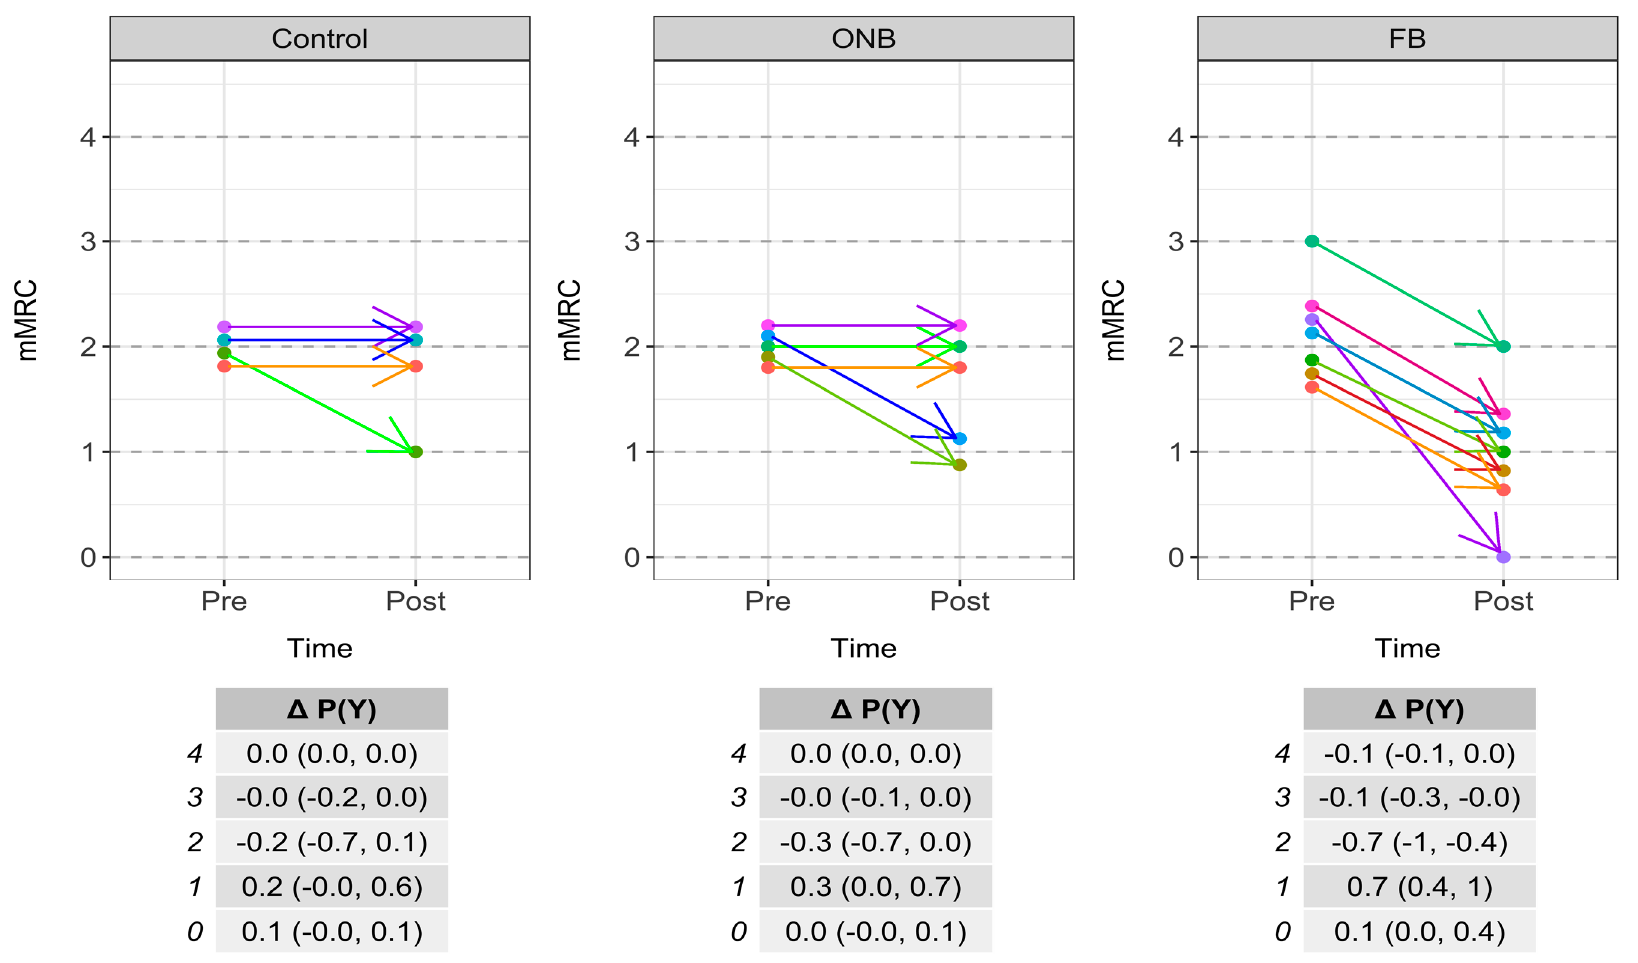
Figure 4. Individual changes and difference ( Δ ) on the probability (P) of response the row Y (i.e., 0, 1, 2, 3 or 4) from pre to post-training in the modified Medical Research Council dyspnea scale (mMRC).